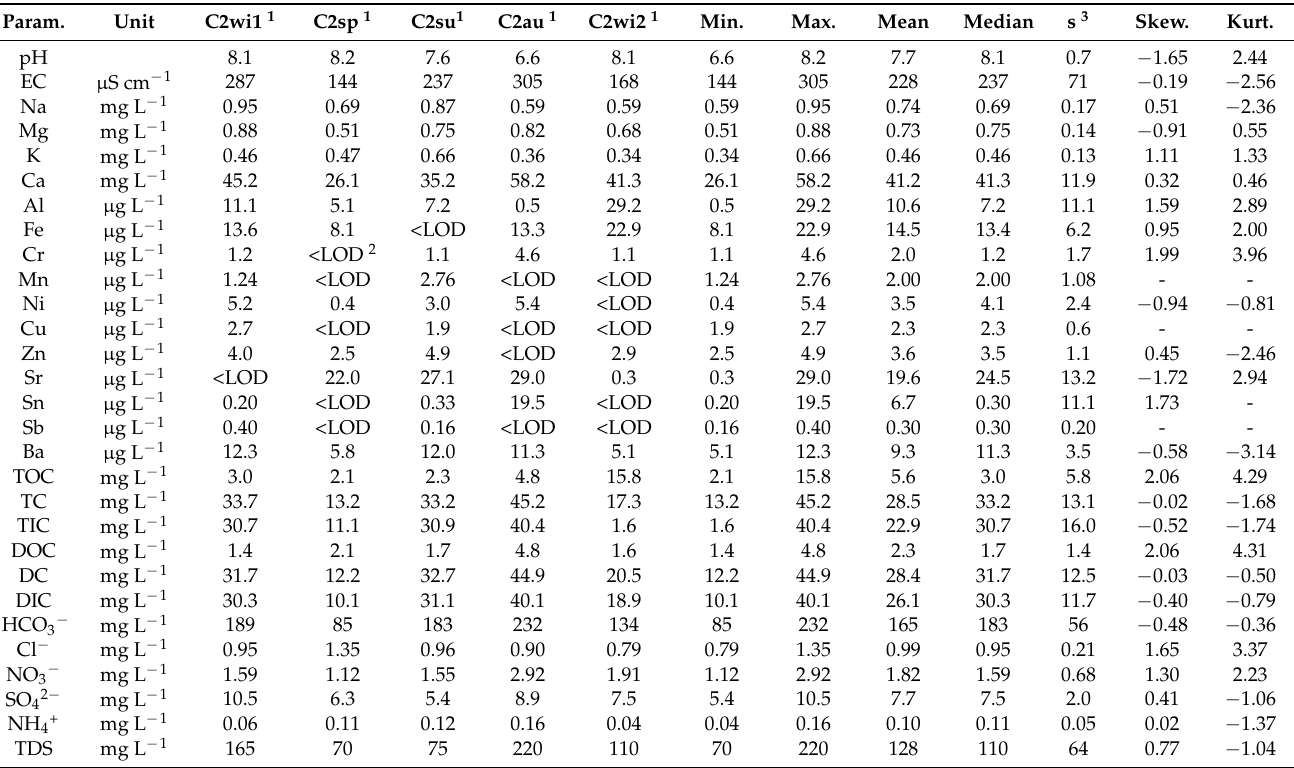
Table 1. Hydrogeochemical characteristics and summary statistics of the water samples seasonally collected from C2. Param.